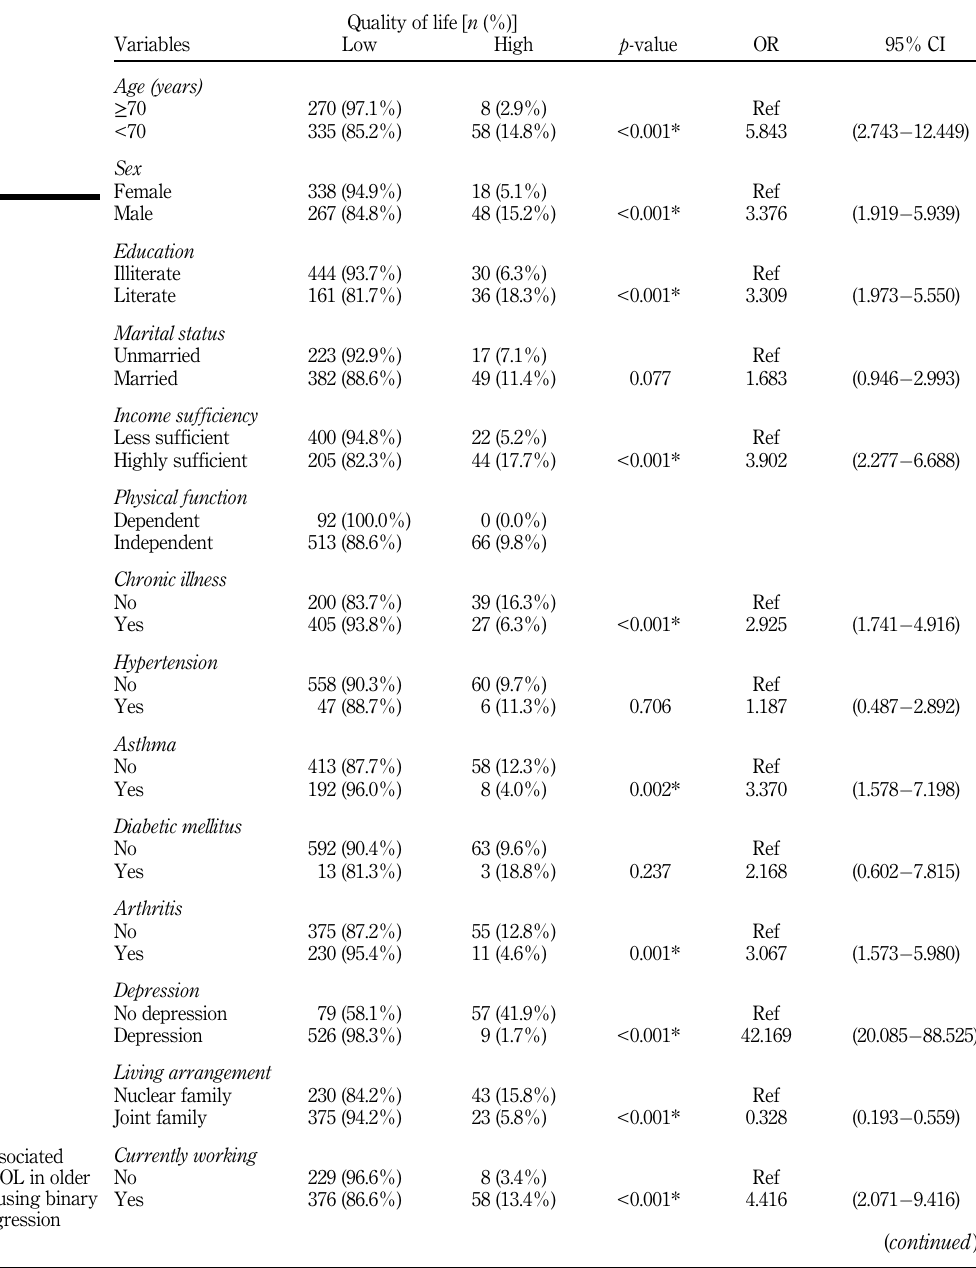
with the QOL in older adults by using binary logistic regression